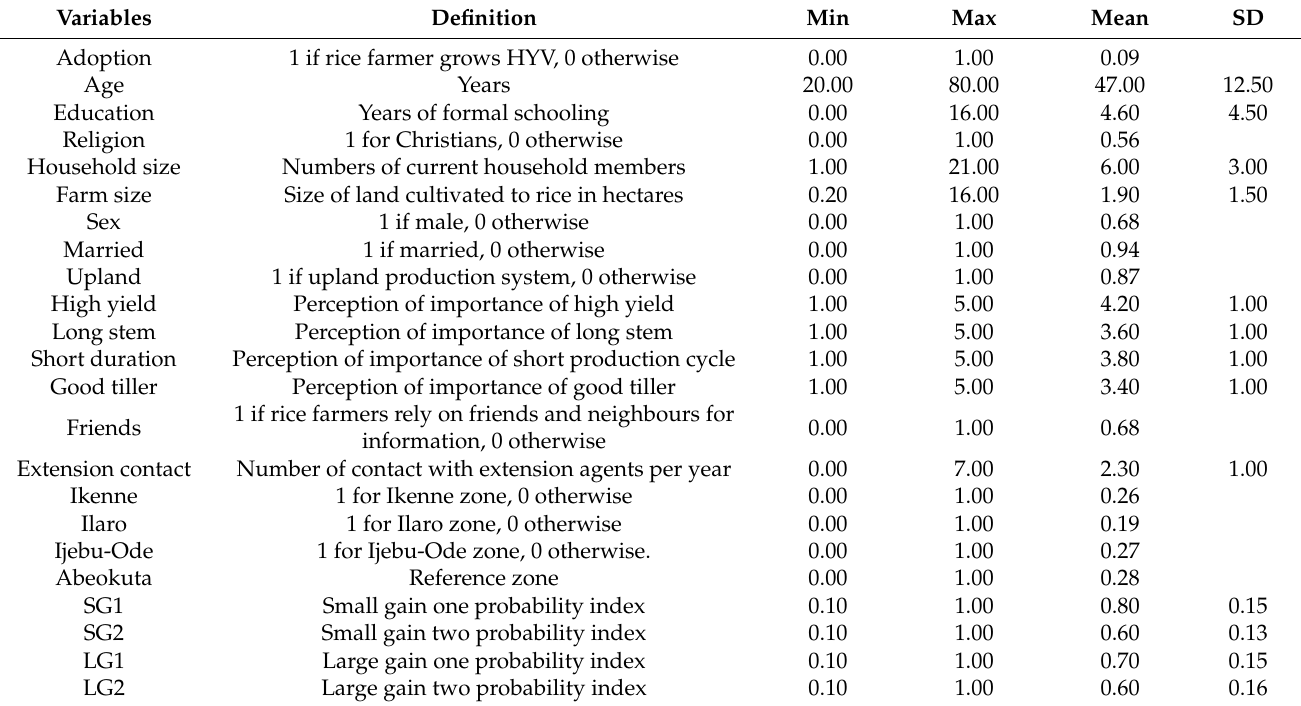
Table 1. Description of the variables used in the adoption decisions